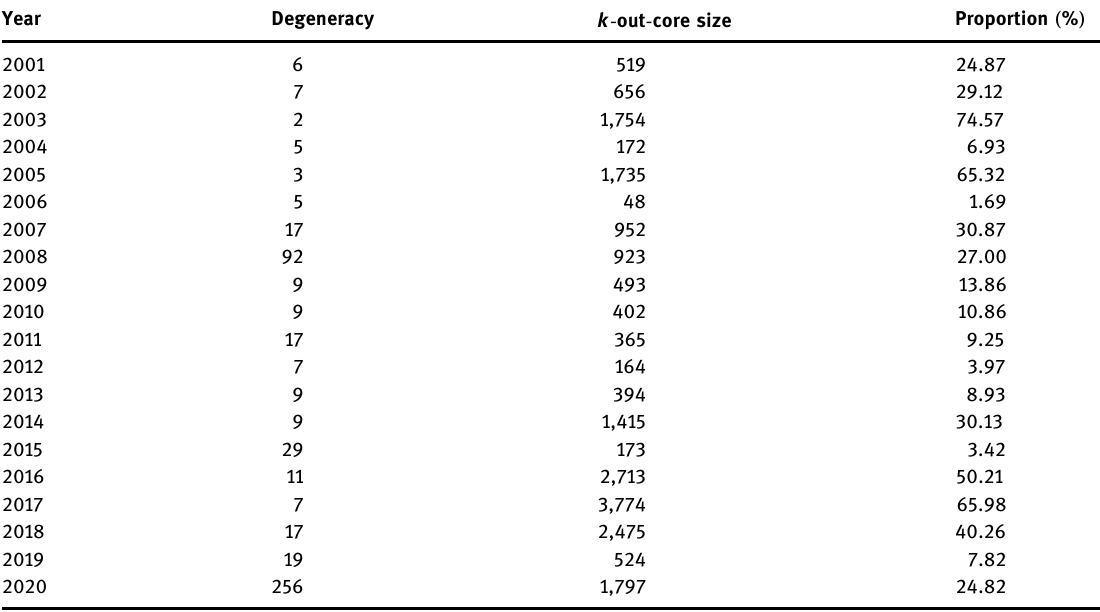
Table 4: k - out - cores in causal market graphs for 2001 –